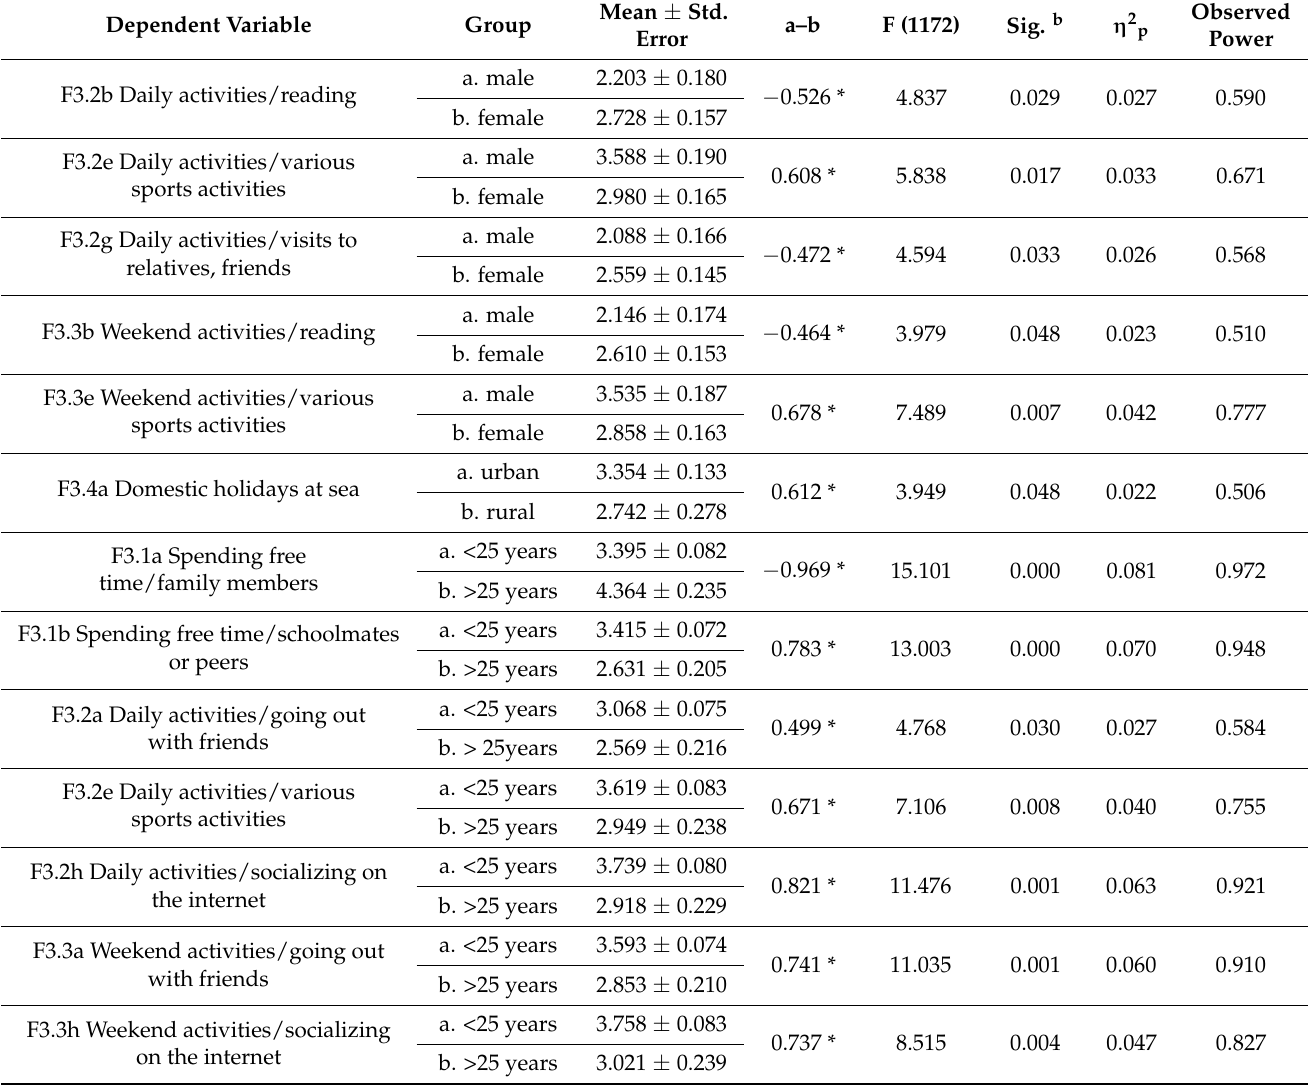
Table 7. The results of univariate tests/ANOVA and the comparison in pairs of the average values at the level of the items for factor 3 (preferred leisure